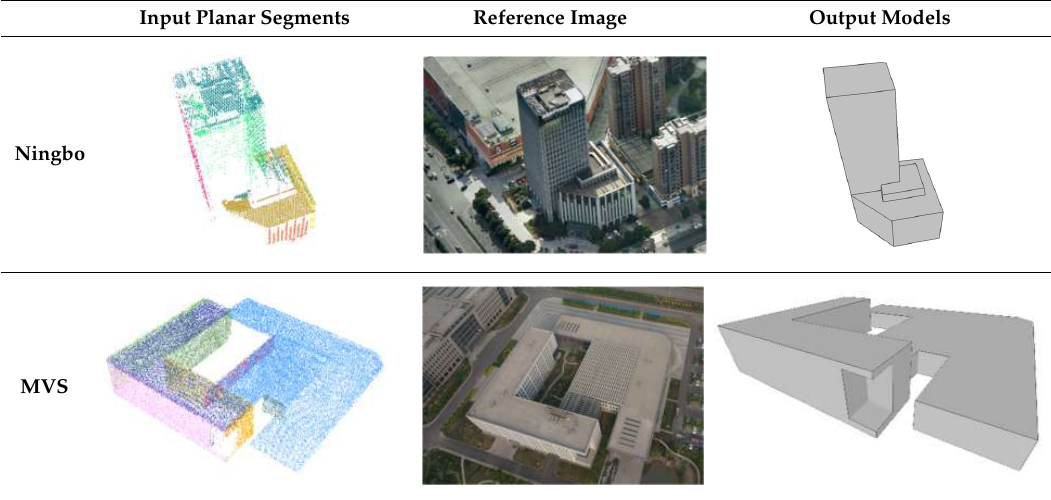
Table 2. Data properties and quantitative statistics.